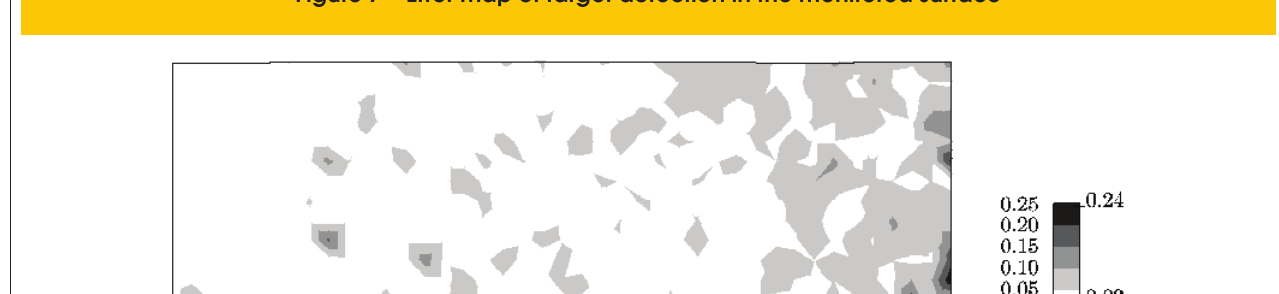
Figure 7 – Error map of target detection in the monitored surface